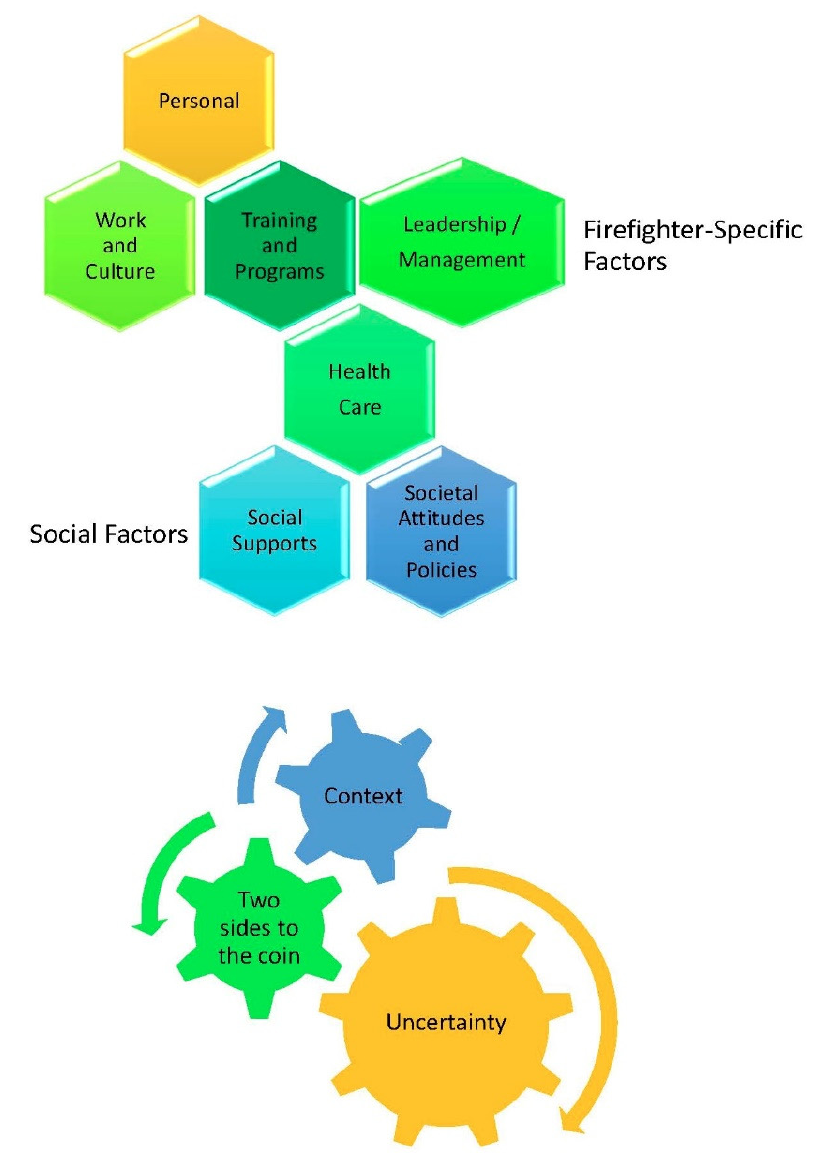
Figure 1. Firefighter Mental Health Themes.